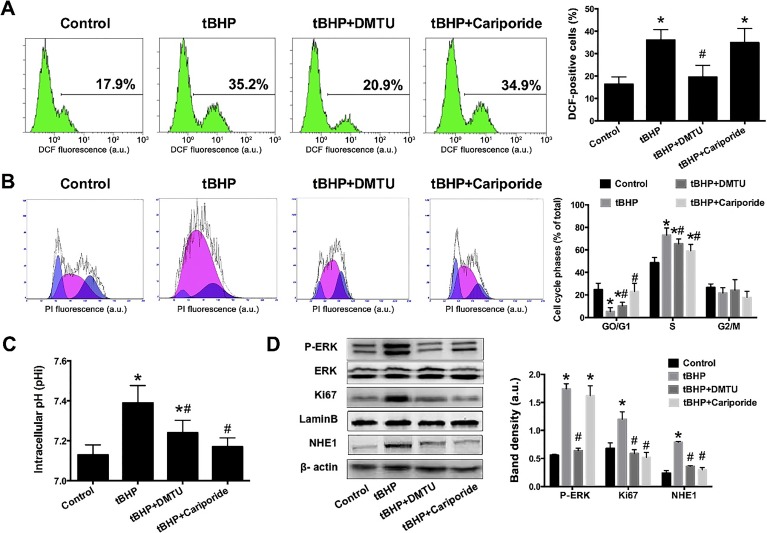
Inhibition of NHE1 decreased ROS-induced OS cell proliferation. Intracellular ROS (A), cell cycle (B), pHi (C), and immunoblots of pERK, Ki67, and NHE1 (D) were assayed after treating U2OS cells with 1 μM tBHP alone or in combination with DMTU or cariporide. Data represent mean ± SD of N = 5. *P < 0.05 versus control. #P < 0.05 versus the tBHP group.